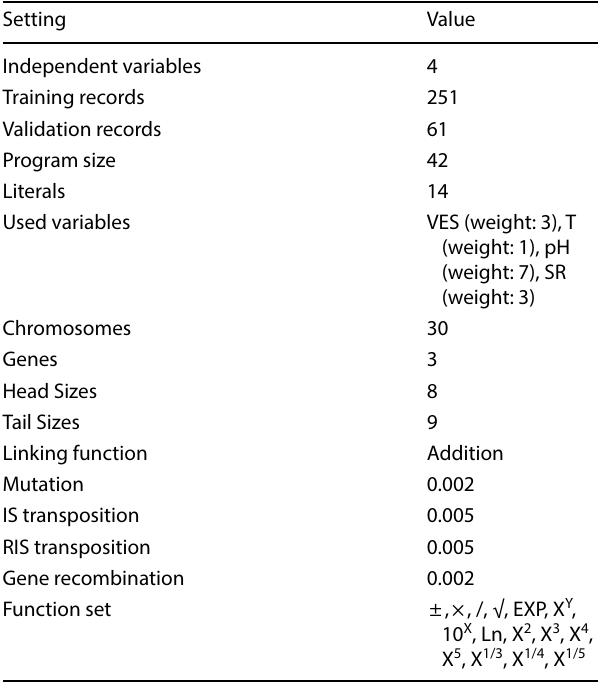
Table 2 The setting parameters of the proposed GEP based model Setting